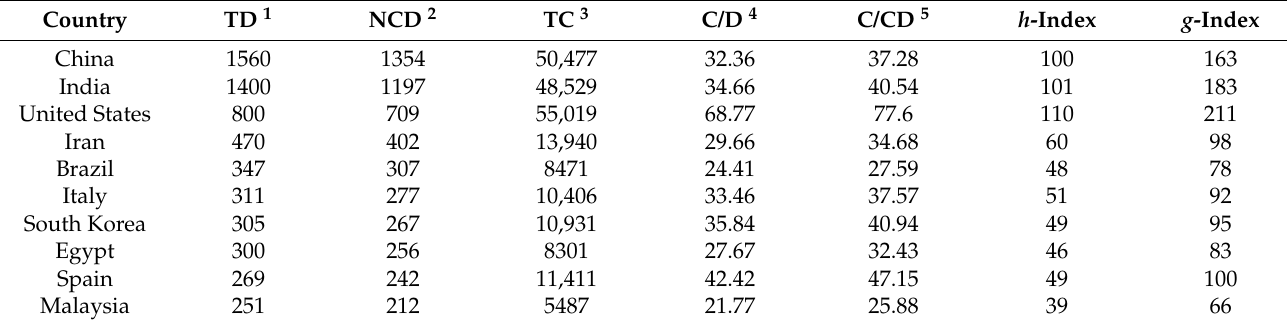
Table 4. Country Contribution.